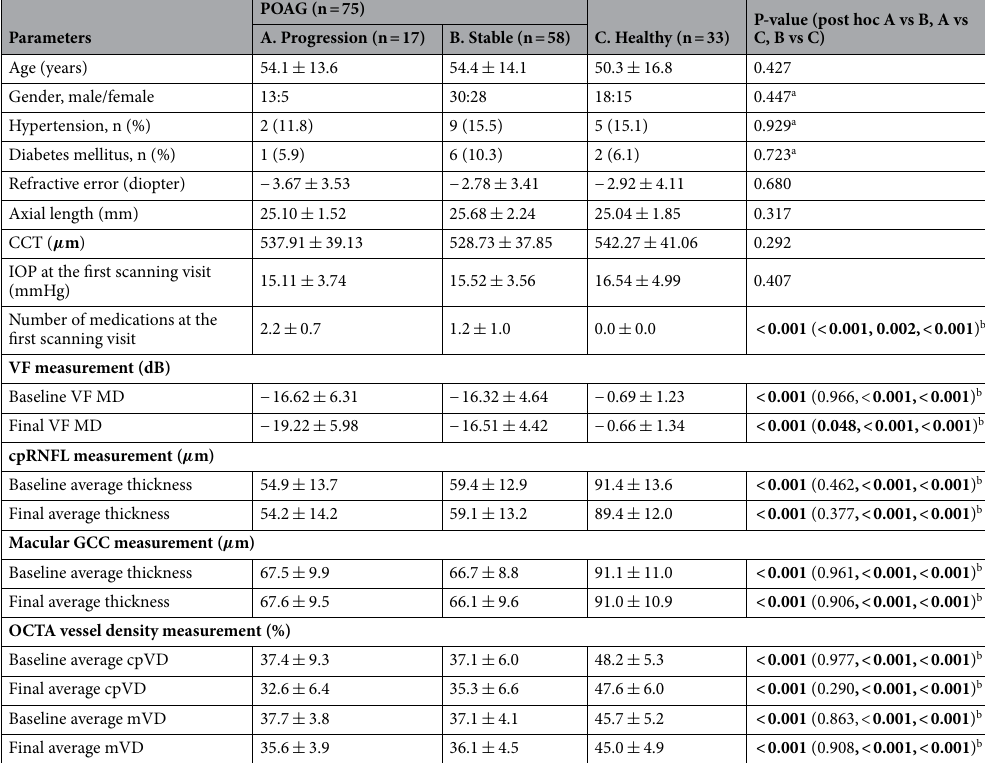
Table 1. Demographics and ocular characteristics of the study population. CCT central corneal thickness, cpRNFL circumpapillary retinal nerve fiber layer, cpVD circumpapillary vessel density, dB decibels, GCC ganglion cell complex, IOP intraocular pressure, MD mean deviation, mVD macular vessel density, n number, OCTA optical coherence tomography angiography, VF visual field. Boldface values indicates statistical significance. a Fisher exact test. b one-way analysis of variance with the Tukey’s post hoc test.